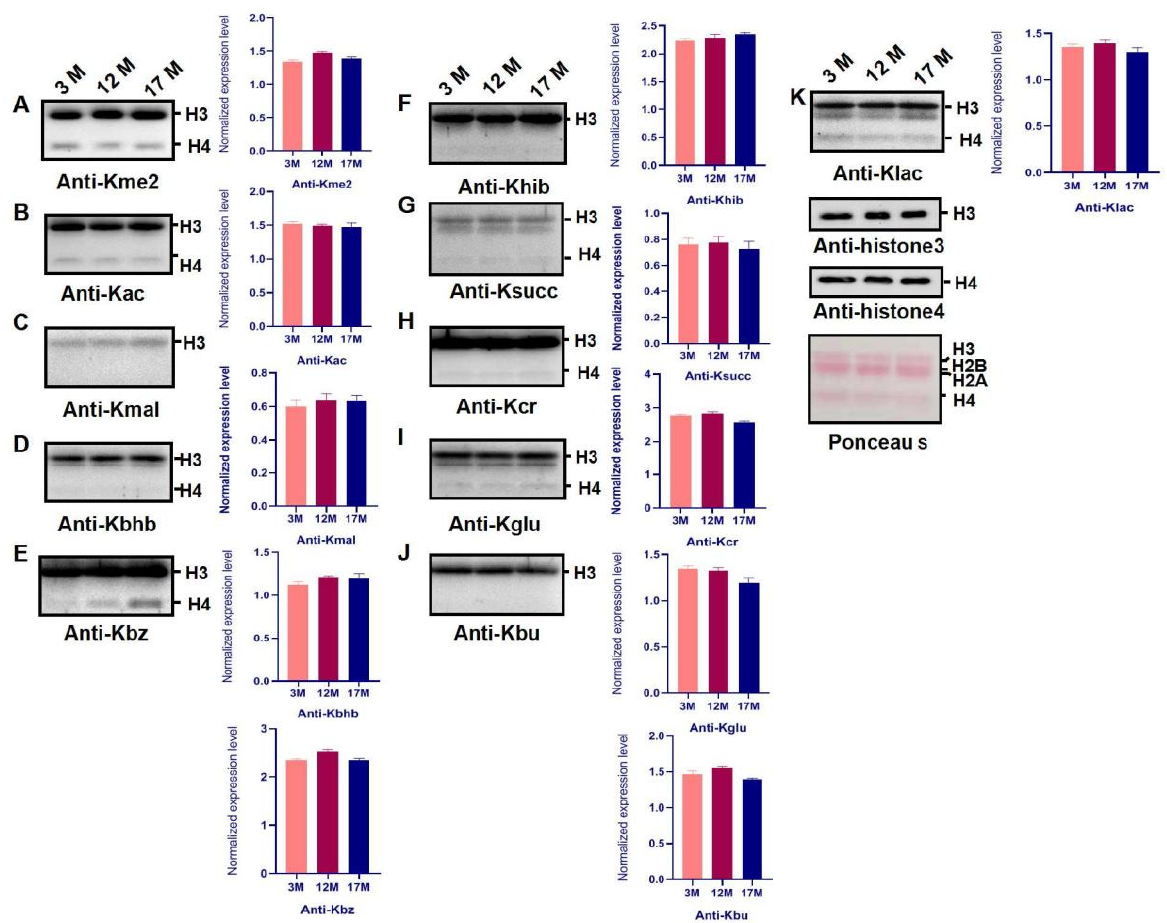
Figure 4. The modification changes of PTMs in histone during ovarian aging of mice. ( A – K ) Ovaries histones in different age of mice were isolated and the level of lysinedi-methyllysine (Kme2), lysine β - hydroxybutyryllysine (Kbhb), lysine2-hydroxyisobutyryllysine (Khib), lysineglutaryllysine (Kglu), lysinemalonyllysine (Kmal), lysinesuccinyllysine (Ksucc), lysinecrotonyllysine (Kcr), lysinebenzoylly- sine (Kbz), lysinebutyryllysine (Kbu), lysineacetyllysine (Kac), and lysinelactyllysine (Klac). Modifi- cations were examined by western blot and analyzed by quantifying the gray value of target bands normalized to those detected by PTMs using Image J software (version1.44, National Institutes of Health, MD, USA). Bar: mean ±